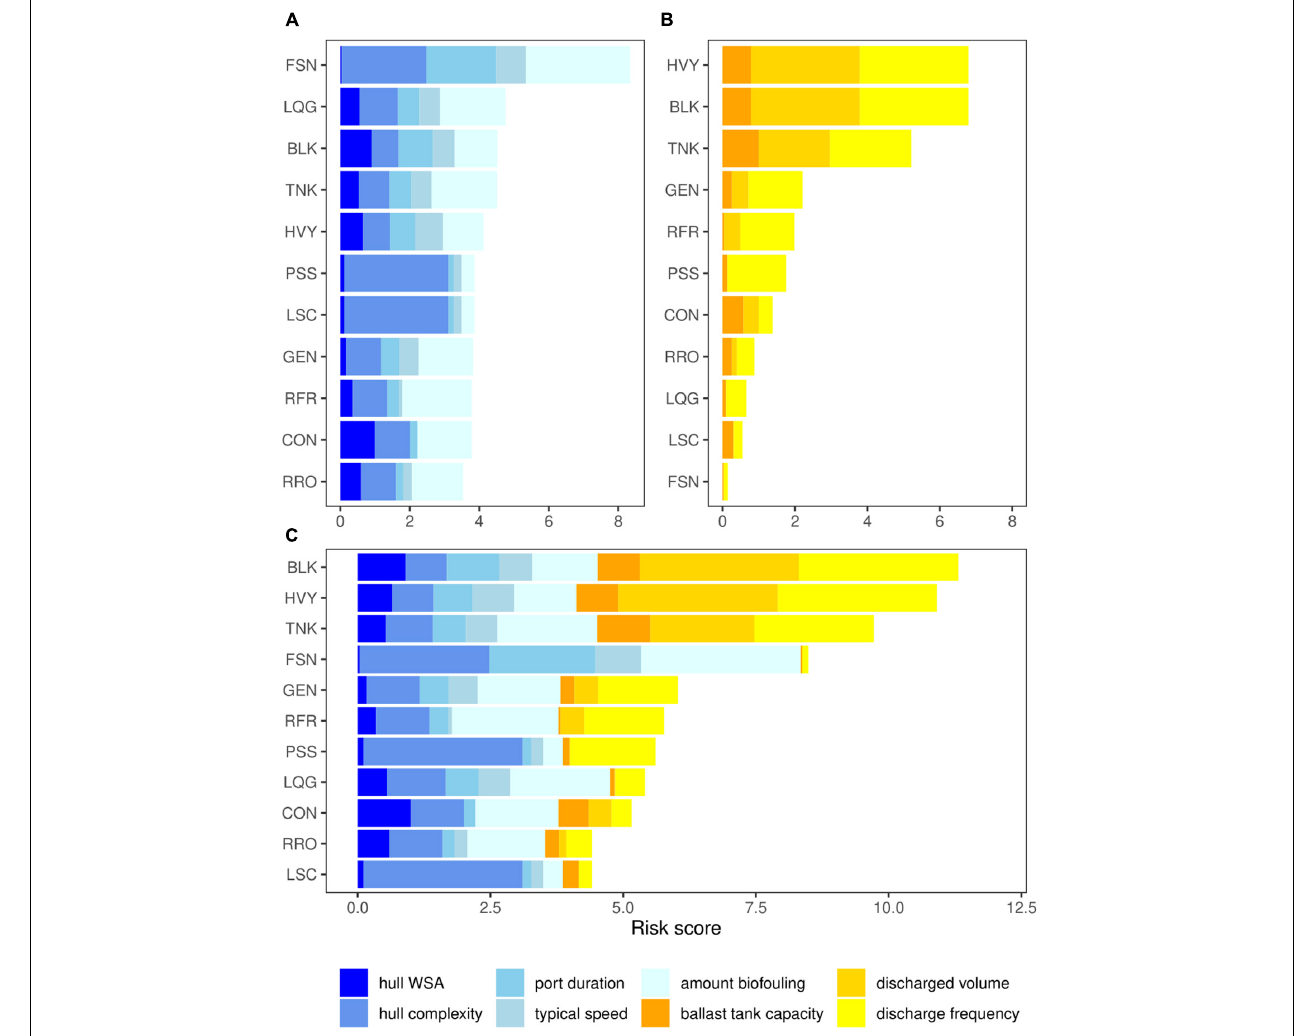
FIGURE 3 | Comparative marine biosecurity risk scores by vessel type. (A) Five biofouling risk factors (blue shaded stacks). (B) Three ballast water risk factors (orange to yellow stacks). (C) Total risk scores across both